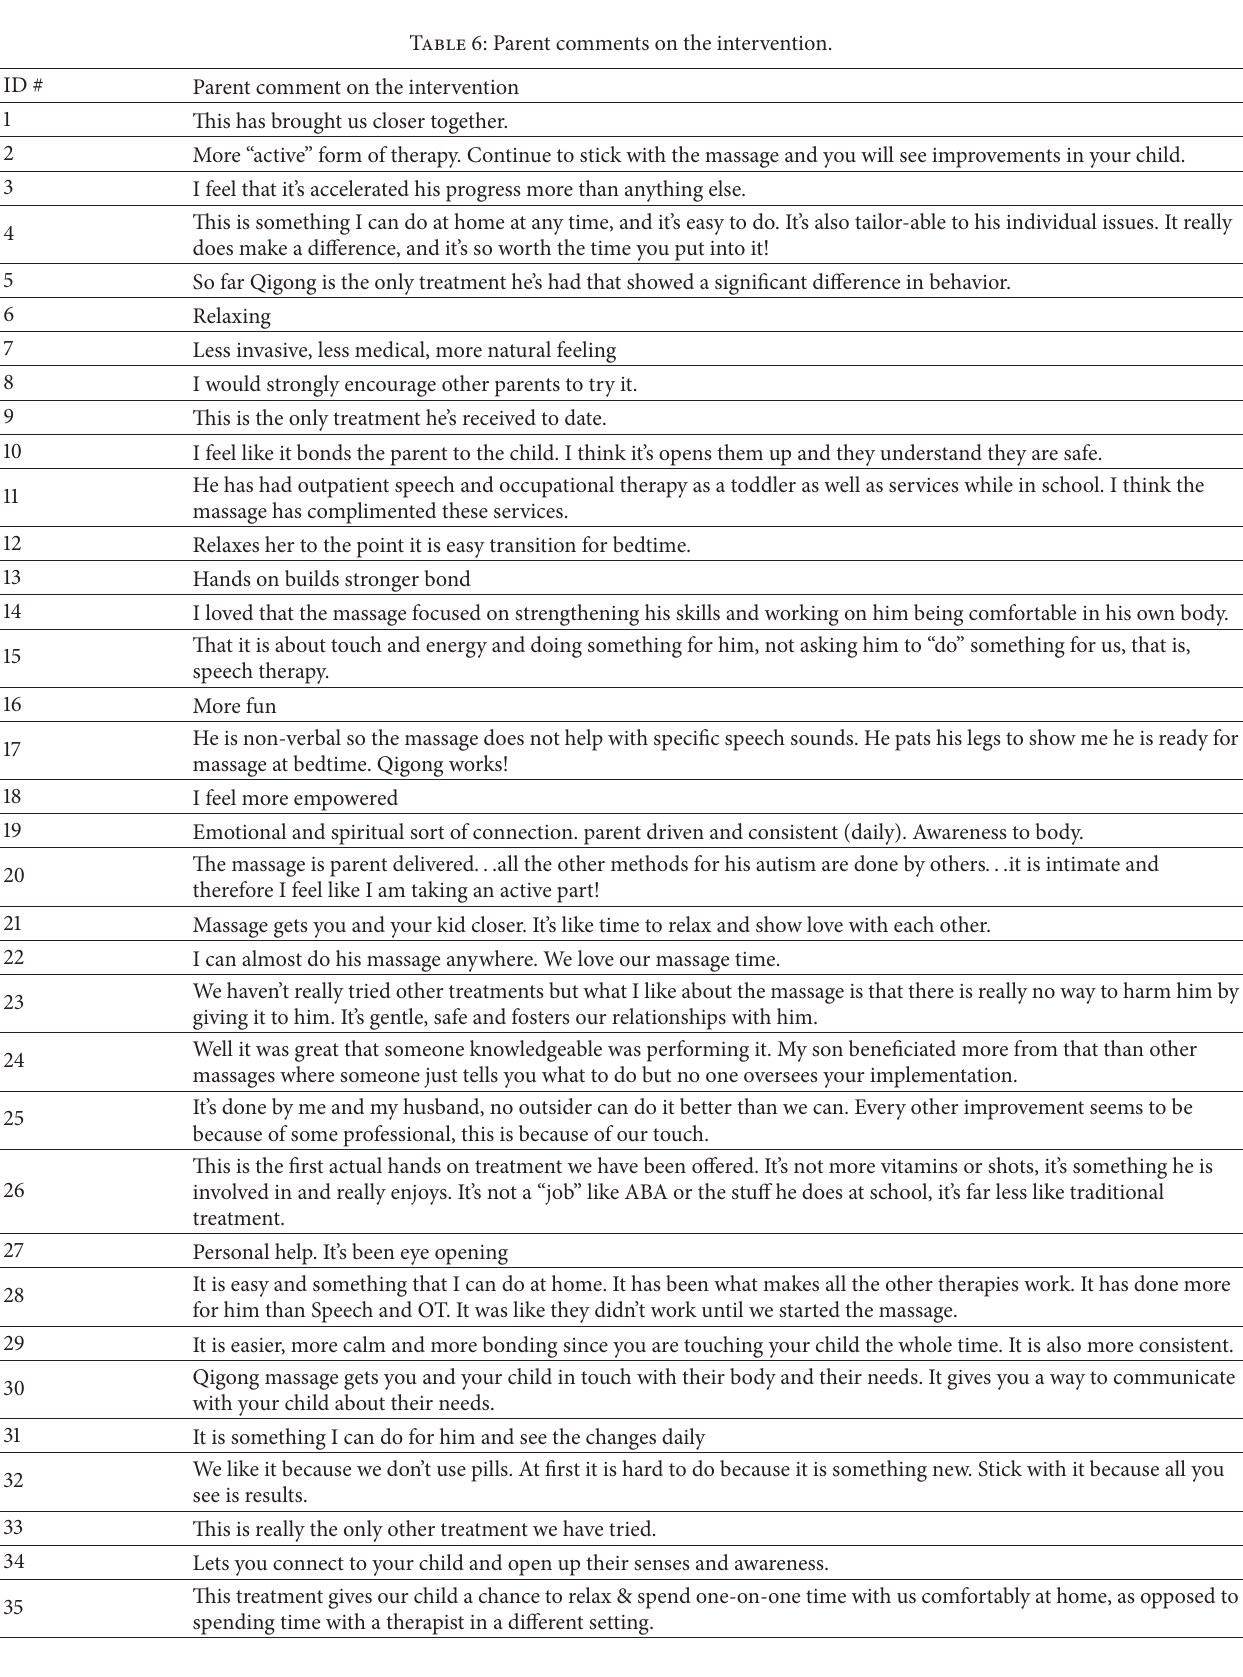
Table 6: Parent comments on the